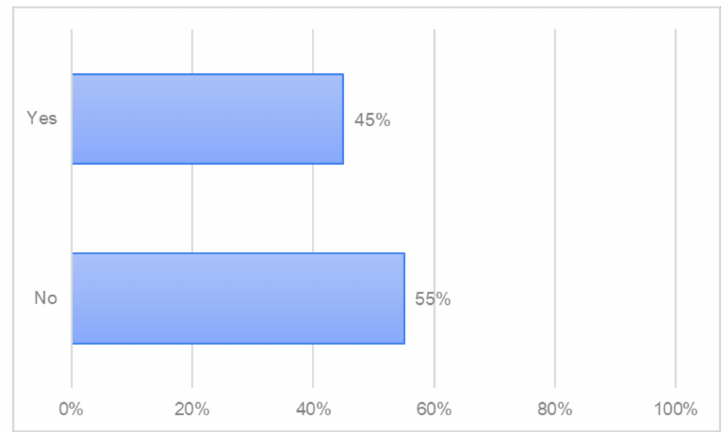
Figure 9. Frequency of burns from the power saw in tree